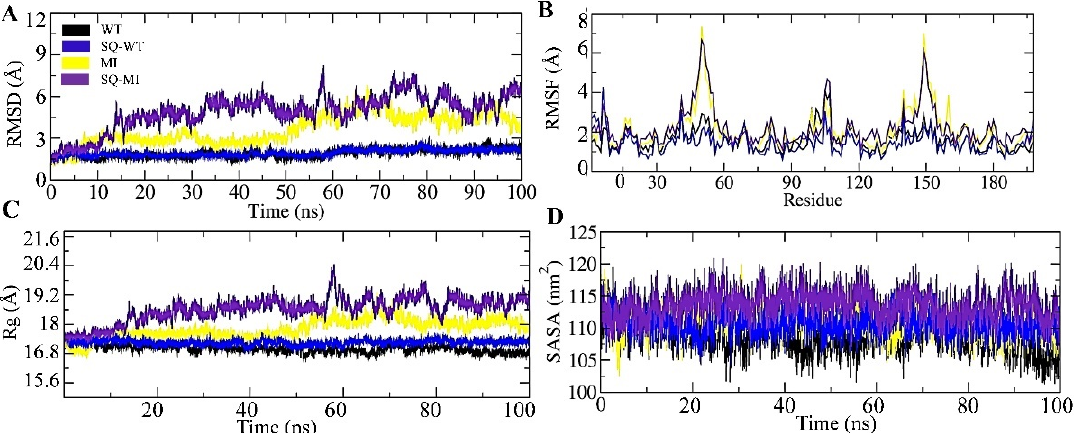
Figure 2. Effect of the M46I mutation on RMSD, RMSF, Rg, and SASA of saquinavir-bound HIV-1 protease. ( A ) RMSF ( B ) RMSF, ( C ) Rg, and ( D ) SASA of WT, SQ-WT, MI, and SQ-MI systems during the 100 ns simulation. The black, blue, yellow, and purple colors represent the WT, SQ-WT, MI, and SQ-MI systems. WT, Wild-type; SQ-WT, Saquinavir bound wild-type; MI, M46I-mutation-carrying protease; and SQ-MI, Saquinavir-bound mutation-carrying